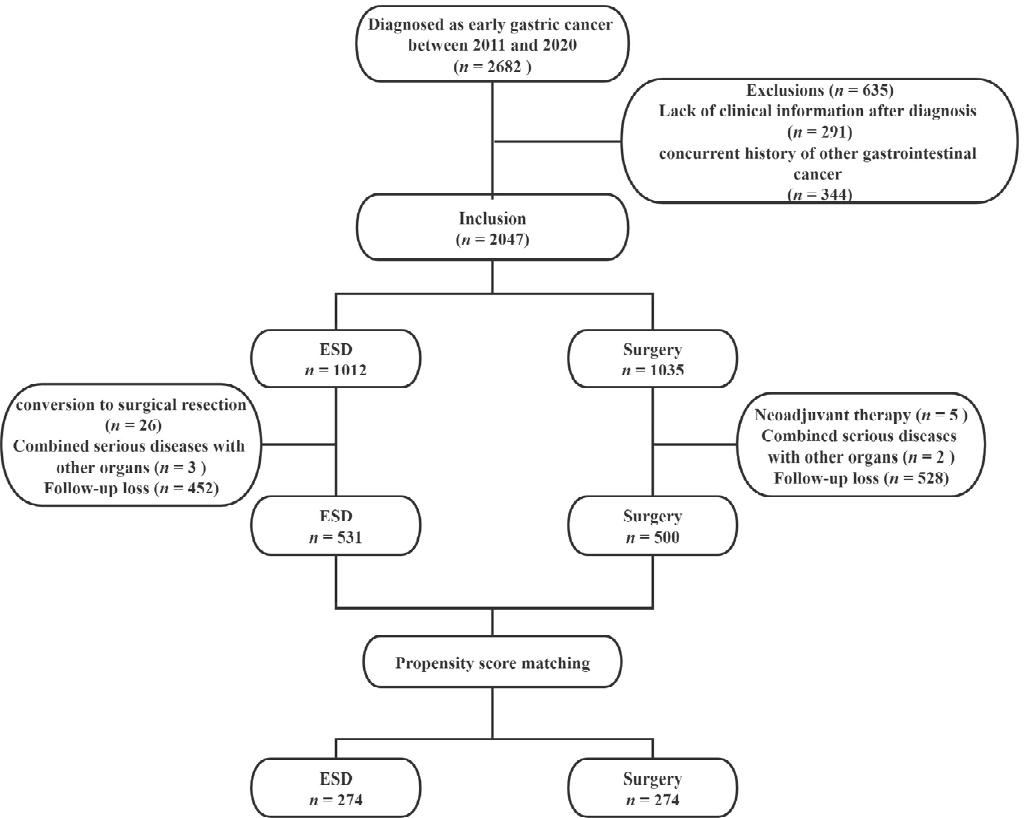
Figure 1. Flowchart of the study population. ESD: endoscopic submucosal dissection.